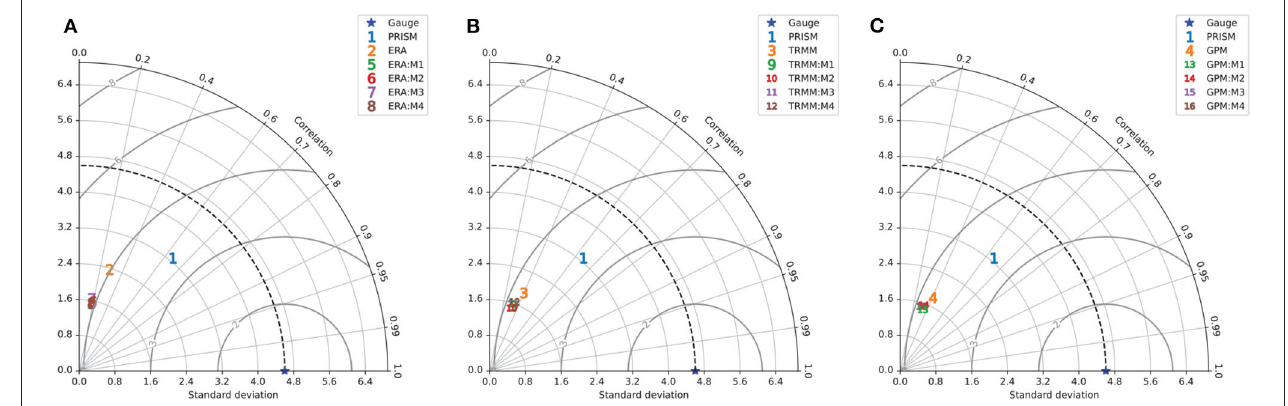
FIGURE 5 | Taylor diagrams summarizing statistics of all gridded rainfall products and uncorrected AU-Net models, against the gauge data and PRISM data for test period (2017/01–2018/12): (A) ERA, (B) TRMM, and (C) GPM. The blue star on the horizontal axes corresponds to the gauge dataset result.